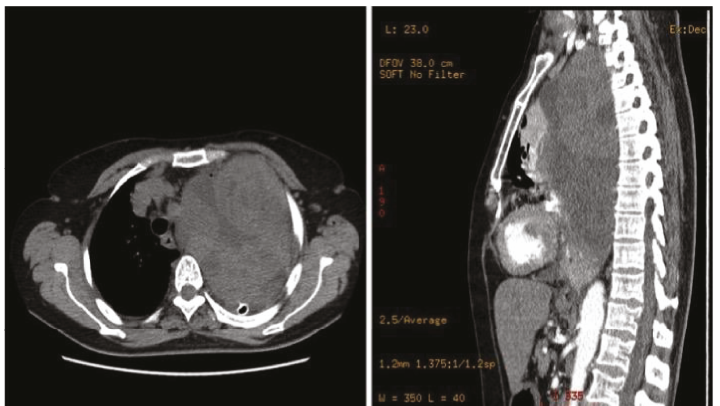
Figure 1: Chest computed tomography scan of an intrapulmonary solitary fi brous tumor, largely occupying the left hemithorax (mediastinal window).